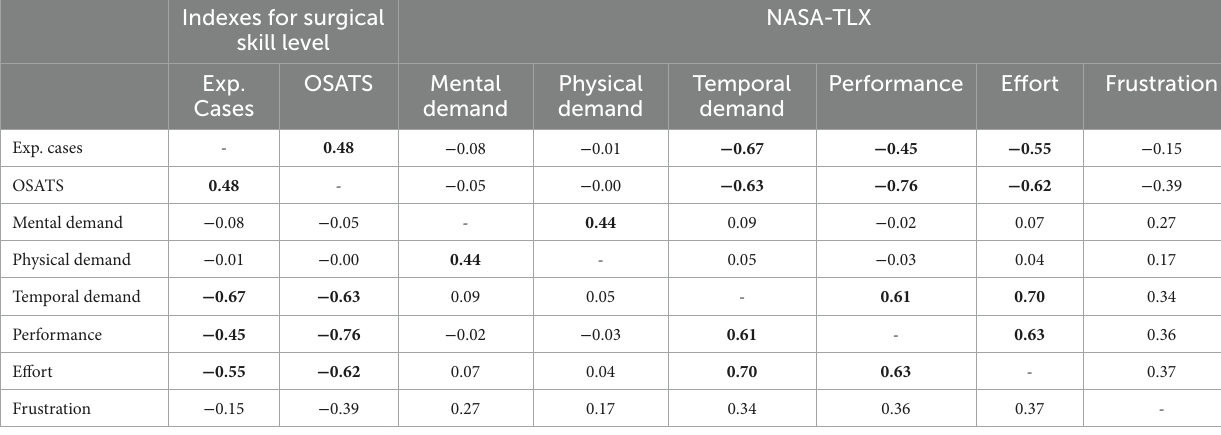
TABLE 2 Correlation coefficient among the surgical skill level of ESS and the subscales of